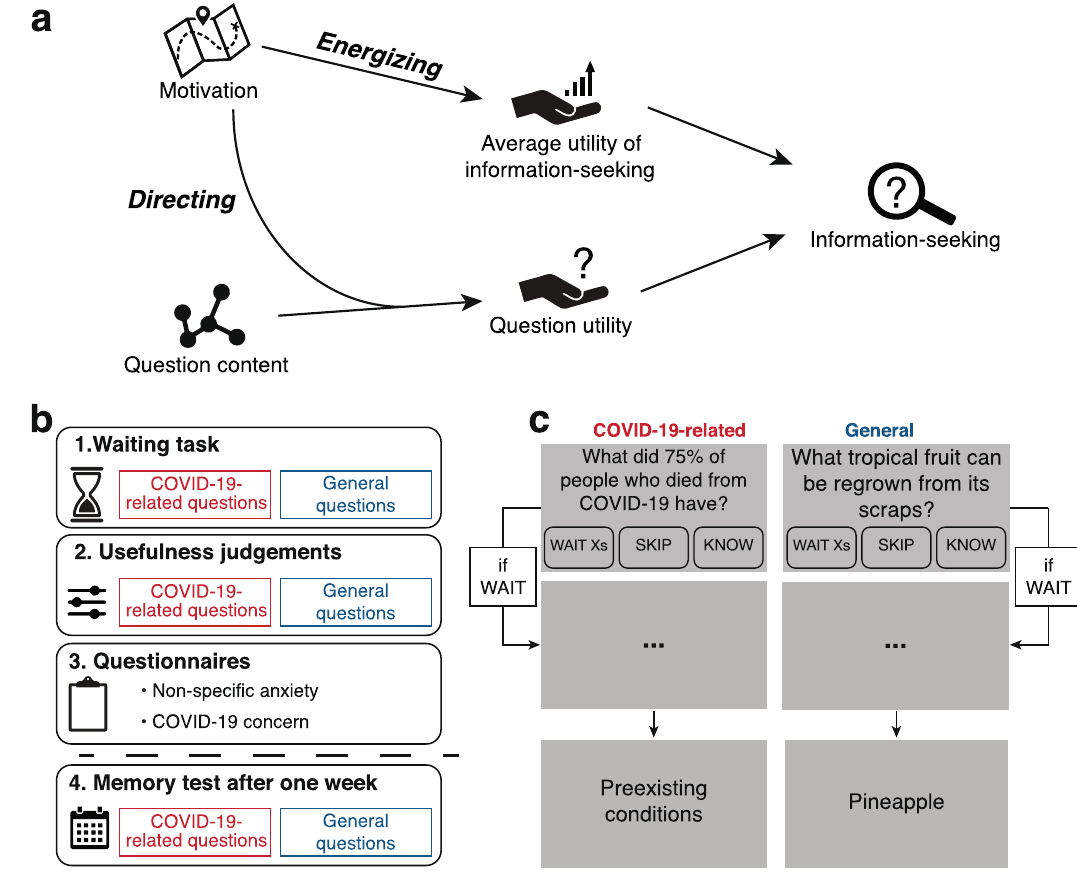
Fig. 1 Measuring the two roles of motivation in information-seeking. a Based on rational theories of motivation, we postulate a dual role for motivation in modulating information-seeking. First, speci fi c motivational states direct information-seeking by assigning greater utility to questions with relevant